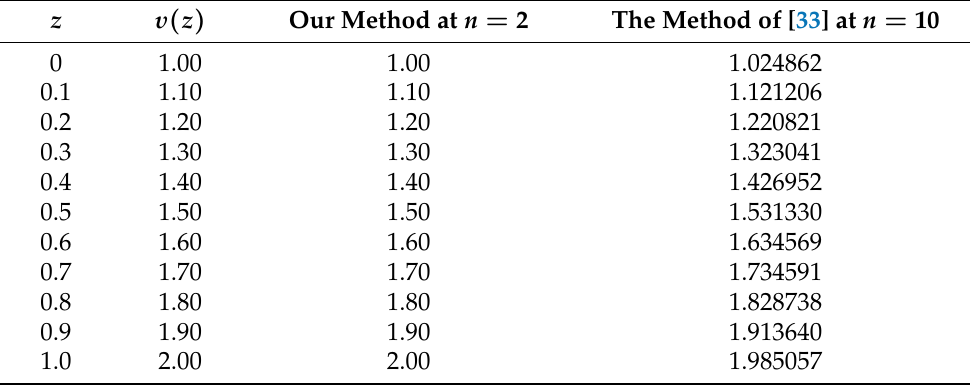
Table 1. Comparison of approximate solution of Example 1.